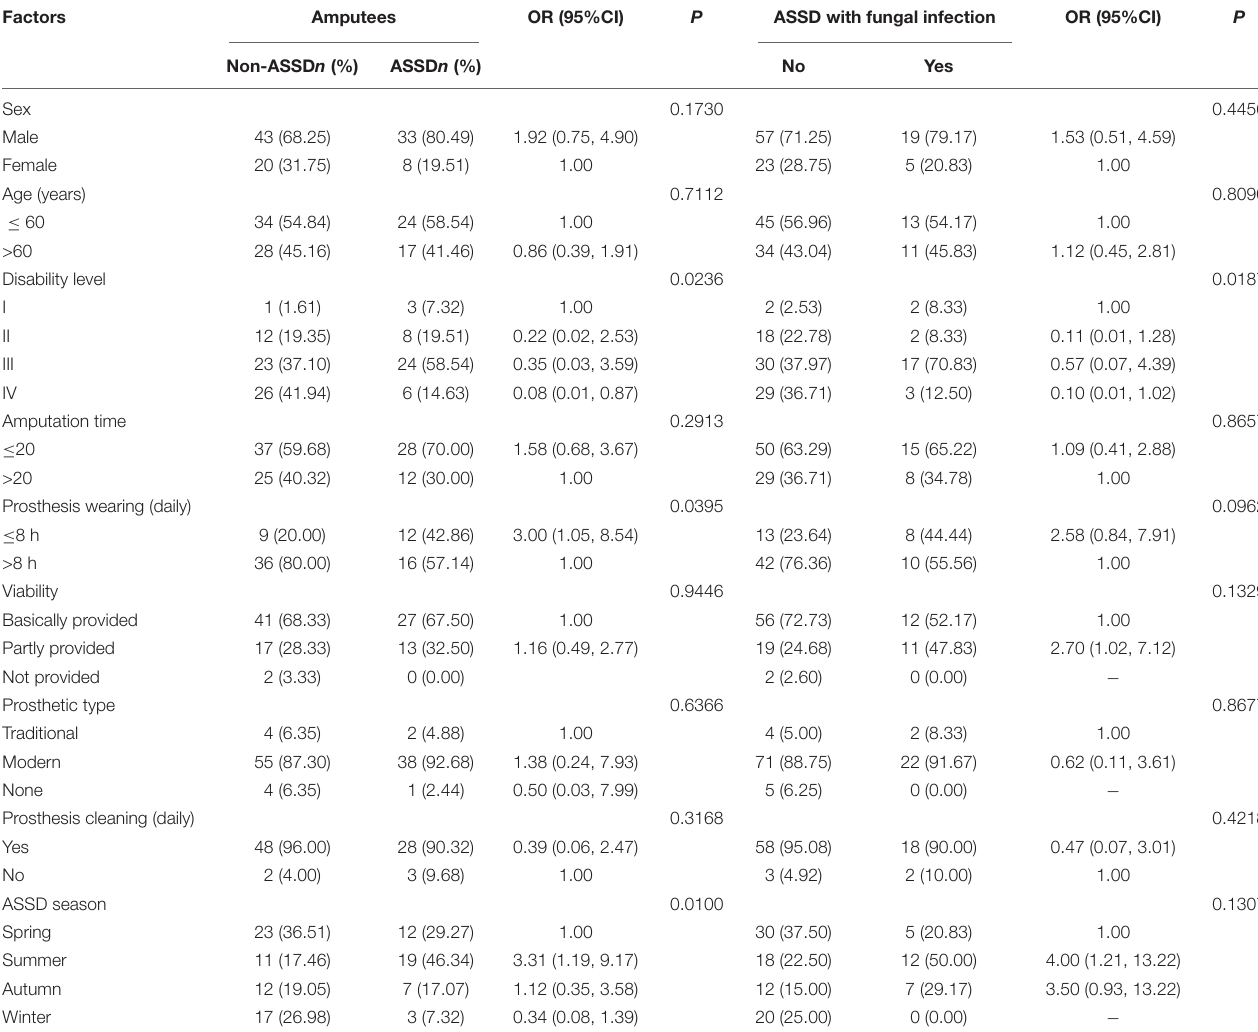
TABLE 4 | Predictors of risk factors for ASSD and skin fungal